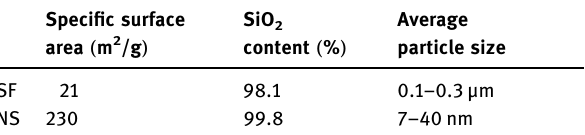
Table 3: Physical properties of SF and NS Speci fi c surface